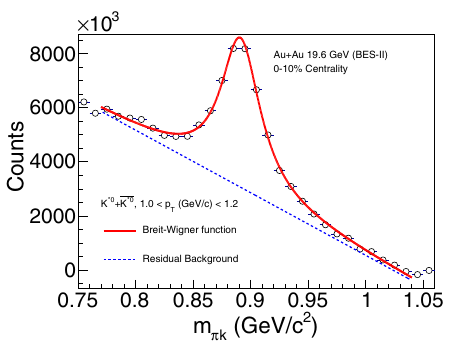
Figure 1. K ∗ 0 signal for 1.0 < p T < 1.2 GeV / c in 0-10% Au + Au collisions at √ s NN = 19.6 GeV.